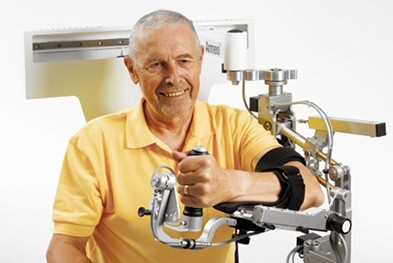
The Armeo Spring, an exoskeleton apparatus with integrated spring mechanism allowing variable upper limb gravity support. Photograph courtesy of Hocoma AG.